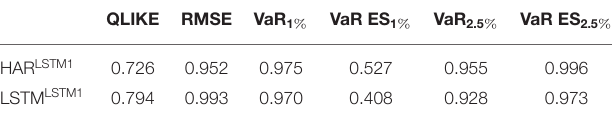
TABLE 4 | p -values of SPA tests for HAR LSTM1 and LSTM LSTM1 against the remaining